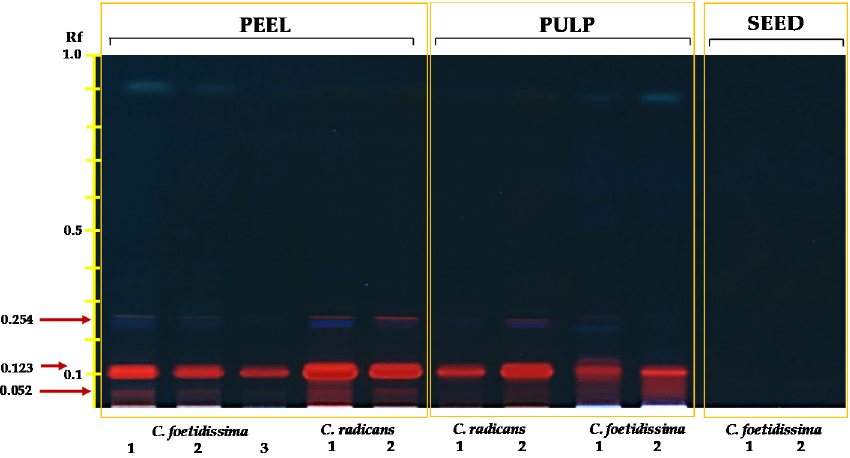
Figure 2. Fluorescent fruit hexane extract profiles of wild Cucurbita species. Hexane extract profiles of seeds, pulp and peel of C. foetidissima and C. radicans fruits were obtained by HPTLC analysis. The fruits were sampled in 2018 from plants growing in the wild in two different locations in the state of Jalisco, México: Vaquerías, municipality of Ojuelos ( C. foetidissima ), and San José de Gracia, municipality of Tepatitlán ( C. radicans ). The red arrows indicate the fluorescent signals obtained when the TLC plates were visualized under UV light (366 nm).